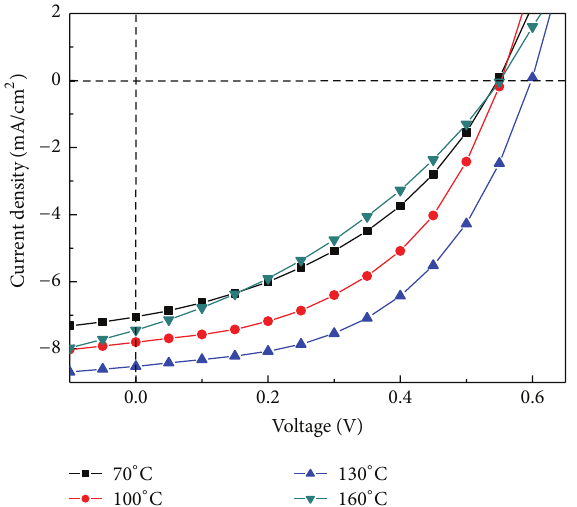
Figure 6: 𝐽 - 𝑉 curves of PSCs with PEDOT:PSS deposited under different temperatures: (a) 70 ∘ C, (b) 100 ∘ C, (c) 130 ∘ C, and (d) 160 ∘